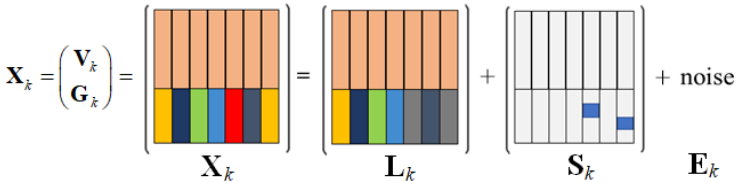
Figure 5. Illustration of low-rank and sparse decomposition. Where L k is the low-rank part, S k is the sparse anomaly part, and E k is the noise